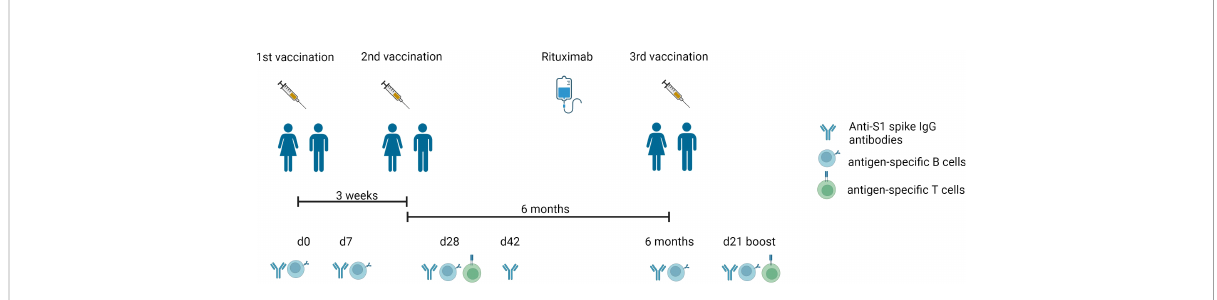
FIGURE 1 Experimental design of the vaccination study. Timeline describing the three-dose vaccination schedule of BNT162b2 mRNA vaccine, blood drawing (d0, d7, d28, d42, 6 months, d21 boost), and RTX treatment between 2 nd and 3 rd vaccination. Anti-S1 spike IgG antibodies, antigen- speci fi c T and B cells were measured as mentioned. Created with